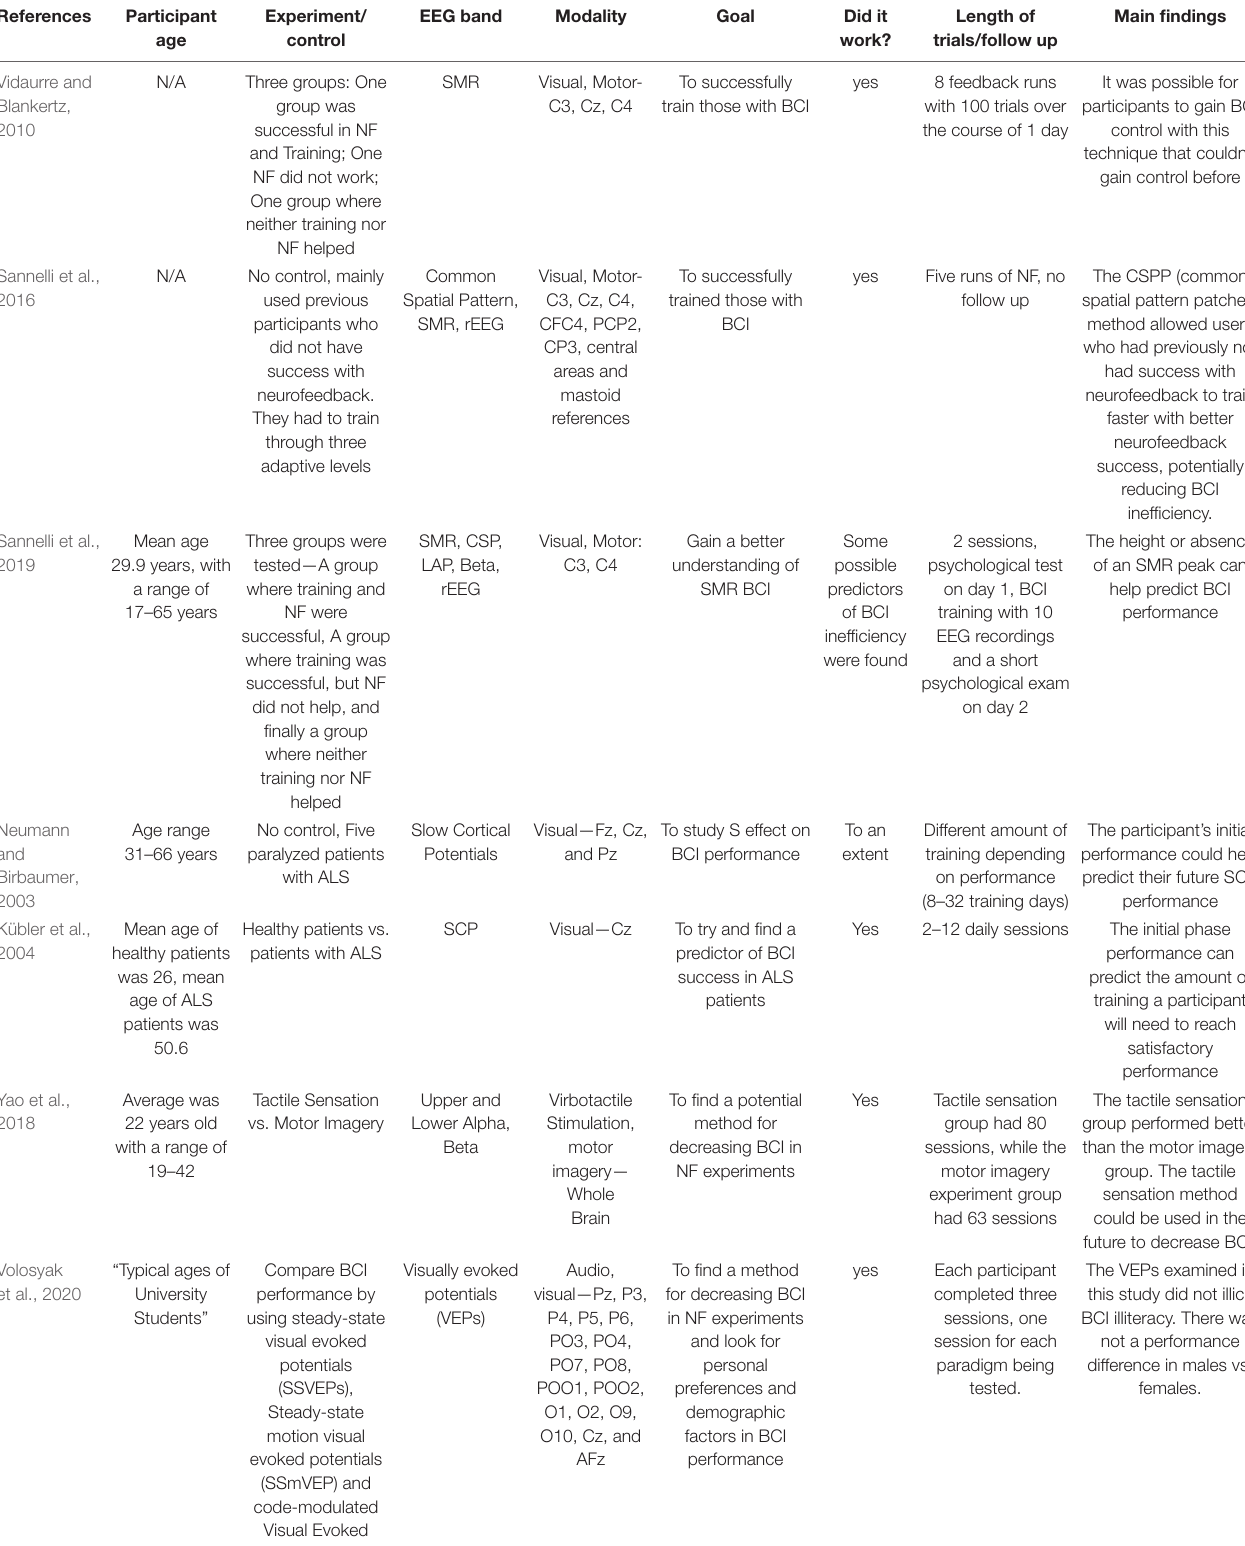
TABLE 4 | Brain-computer Interface (BCI) training in healthy adults and